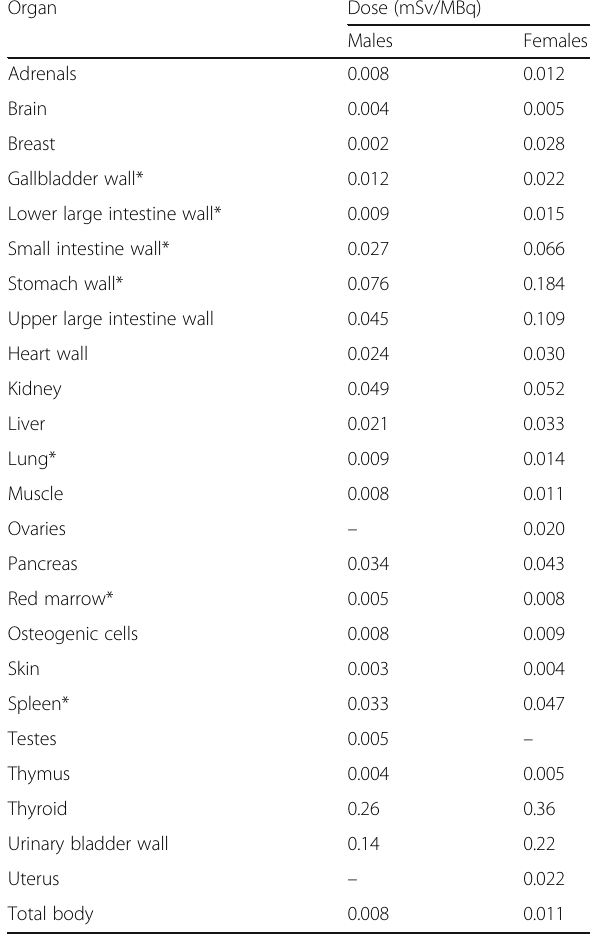
1: Table S2). No significant differences between pre- and